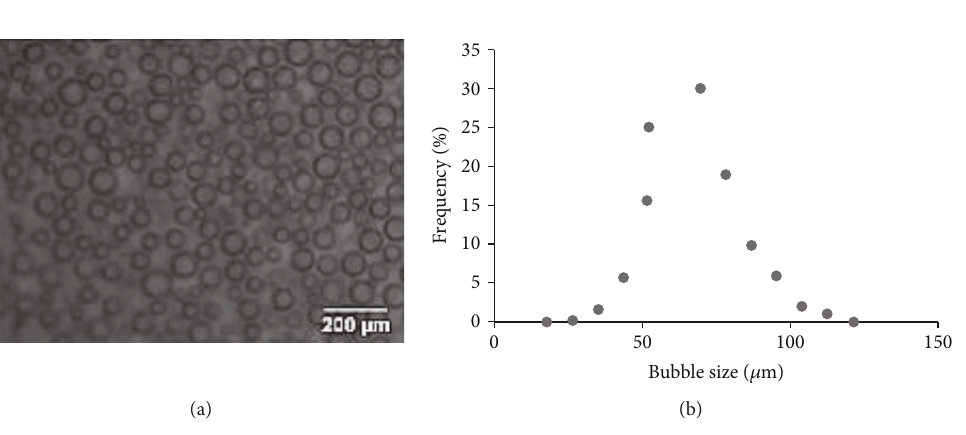
recipe. The same distribution pro fi les were 2 /HAp) used (data not shown). 2